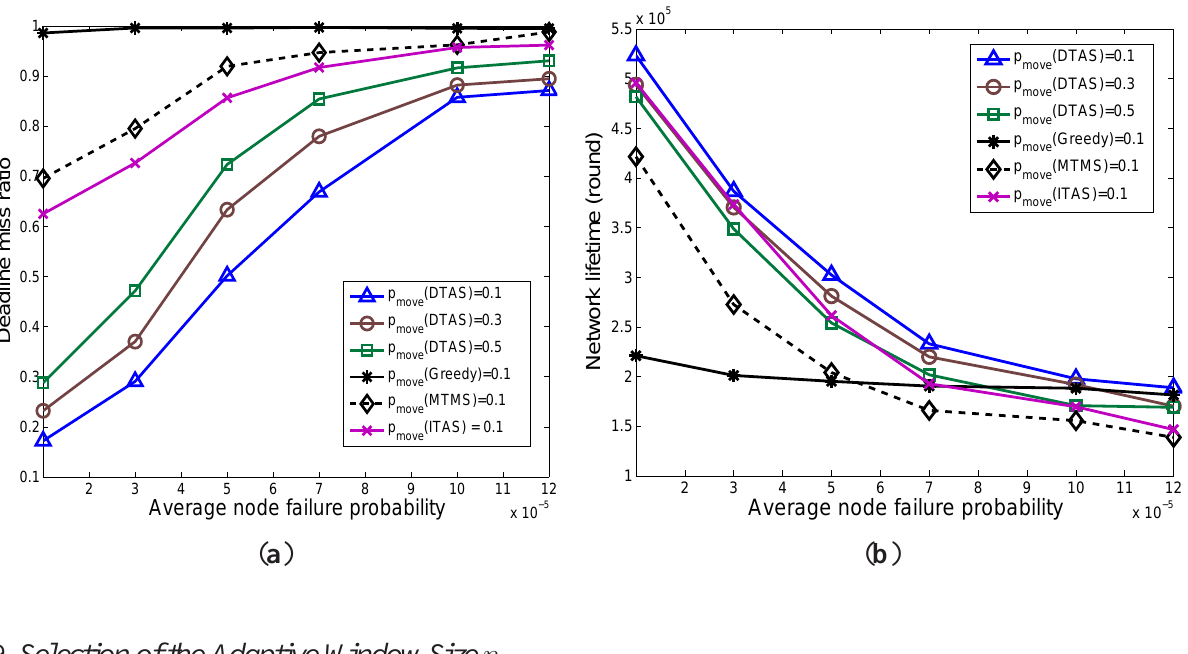
Figure 14. The effect of the average node failure probability ( λ ). ( a ) Deadline miss